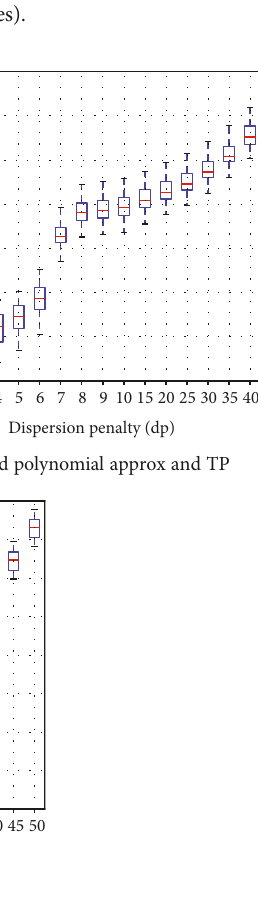
Figure 5: Boxplot diagrams showing fl ight dispersion results for di ff erent dp values.